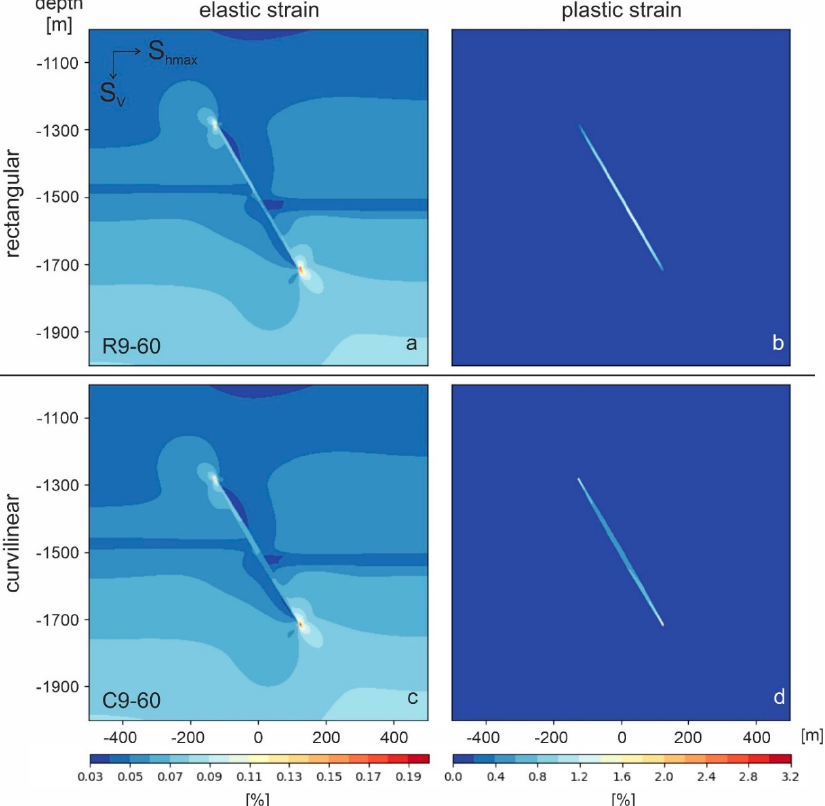
Figure 13. Results after the last load step for a 9-element wide fault zone with 60° dip embedded with different grids. Rectangular grid: ( a ) total von Mises elastic strain (S1). ( b ) total von Mises plastic strain. Curvilinear grid: ( c ) total von Mises elastic strain (S1). ( d ) total von Mises plastic strain. Energies 2020 , 13 , 2673